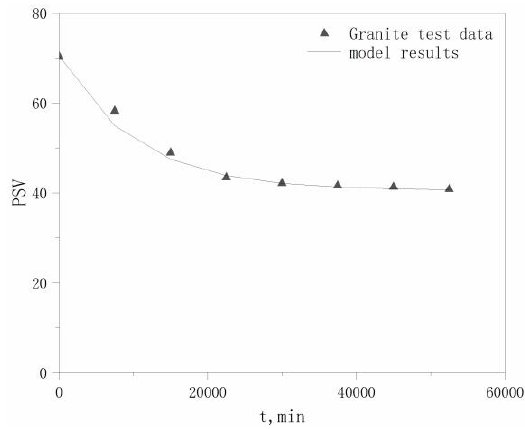
Fig. 7 Modeled and tested PSV results for limestone. Figure 7. Modeled and tested PSV results for limestone.